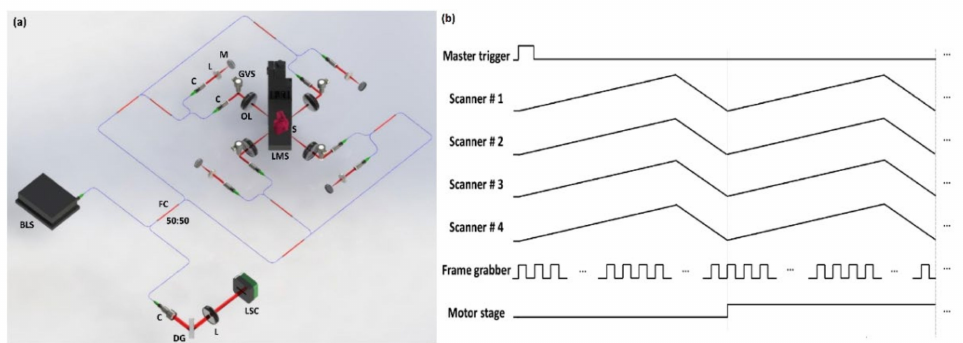
Figure 1. The optical configuration and duty cycle illustration of the simultaneous quad-scanner (QS)-OCT system. ( a ) Simultaneous QS-OCT with space-division multiplexing for simultaneous whole-directional imaging. ( b ) The duty cycles of simultaneous QS-OCT system operation. BLS, broadband light source; C, collimator; DG, diffraction grating; FC, fiber coupler; GVS, galvanometer scanner; L, lens; LMS, linear motor stage; LSC, line-scan camera; OL, objective lens; S,